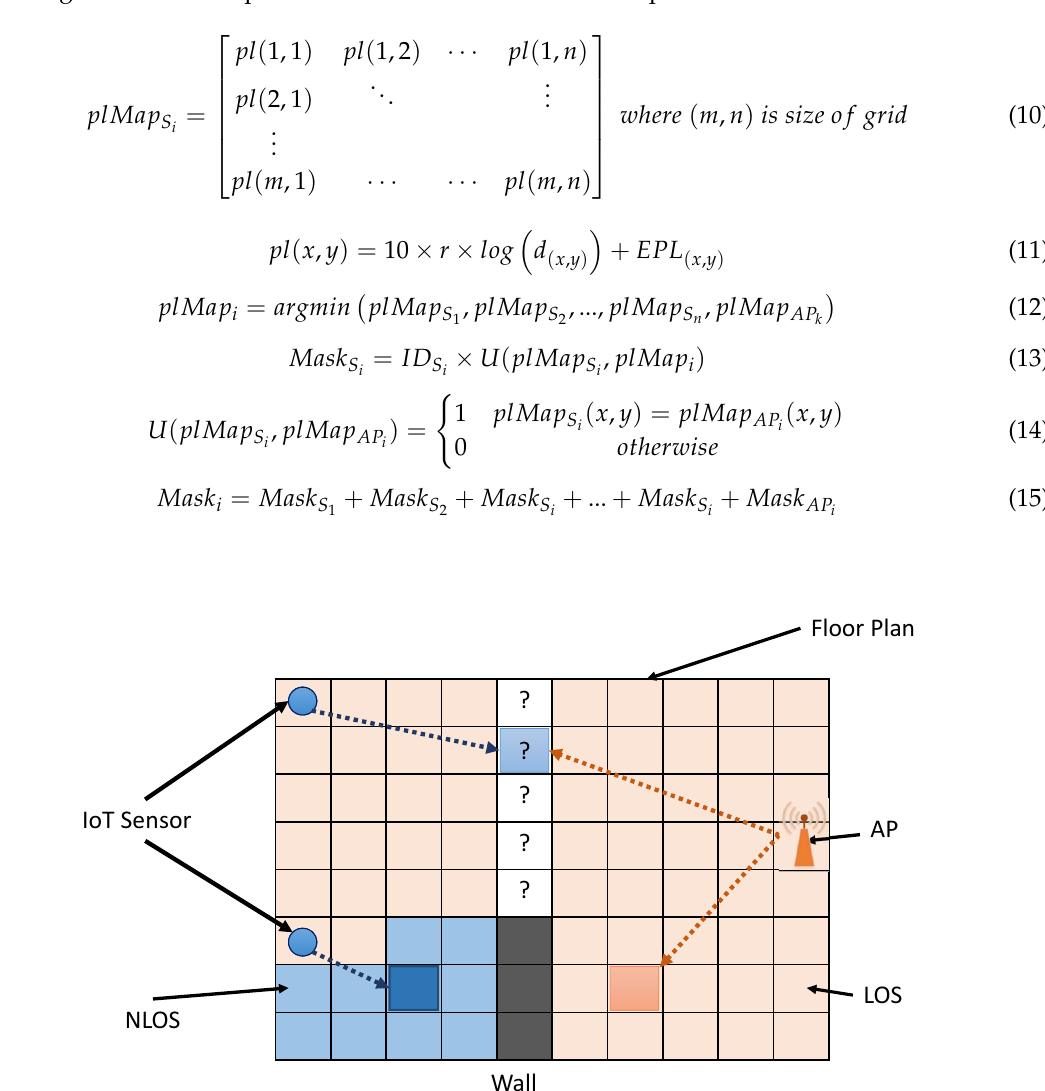
Figure 8. Selection of the contribution device for the estimation of RSSI. AP; Access point with the corresponding LOS; Line-of-sight region (light pink color) and the NLOS; NON-line-of-sight region (light blue color) which is the LOS region for the sensor. The white color cells with ‘?’ represent the regions that are in the LOS case for both kind of devices i.e., the sensor and the access point, and require the designation of a contributing device with respect to the minimal path